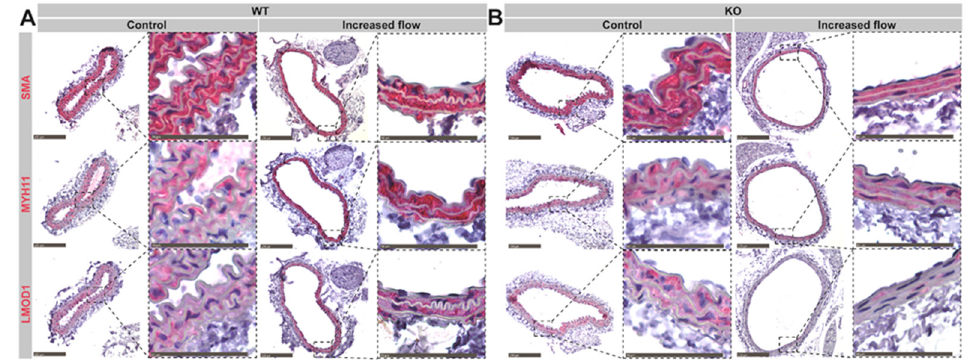
Figure 5. The influence of PCSK6 deficiency on the expression of typical smooth muscle cell markers upon increased flow in the right common carotid artery. Representative images of the carotid arteries stained for smooth muscle alpha-actin (SMA), myosin heavy chain 11 (MYH11) and leiomodin-1 (LMOD1) from ( A ) WT and ( B ) KO mice under normal (WT n = 2, KO n = 4) and increased flow conditions (WT n = 4, KO n = 4). KO = Pcsk6 − / − mice. WT = C57Bl/6J mice.